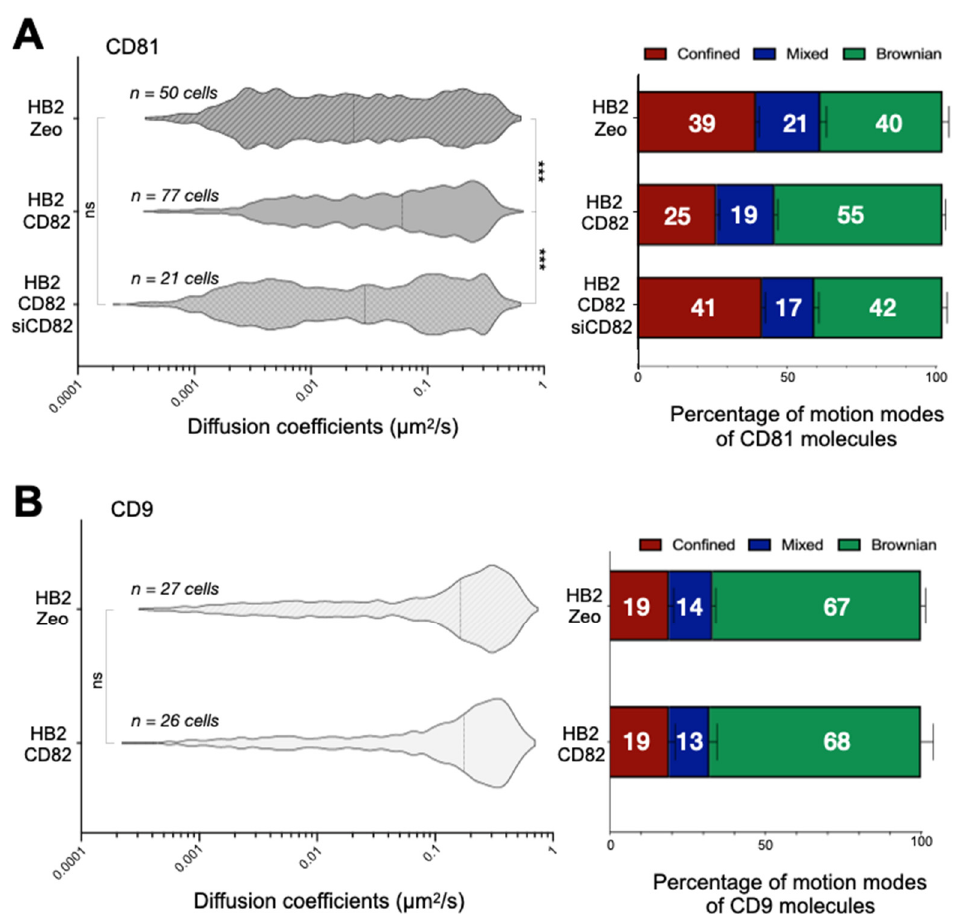
Figure 2. Left Panels: Distribution of the apparent diffusion coefficients calculated for all individual CD81 ( A ) or CD9 ( B ) molecules at the plasma membrane of HB2/CD82, HB2/zeo cells or HB2/CD82 transfected with siRNA targeting CD82. The violin plots were built with 1000 trajectories for each tetraspanin. The dotted lines indicate the median of the populations. *** indicate that the difference between the populations is significant with a p value below 0.0001 as determined by the Mann–Whitney U test («ns» for non-significant). Right Panels: Histograms representing the percentage of CD81 ( A ) or CD9 ( B ) molecules exhibiting Brownian, confined and mixed motion relative to the total number of trajectories. The error bars represent the standard deviation of at least three independent experiments.